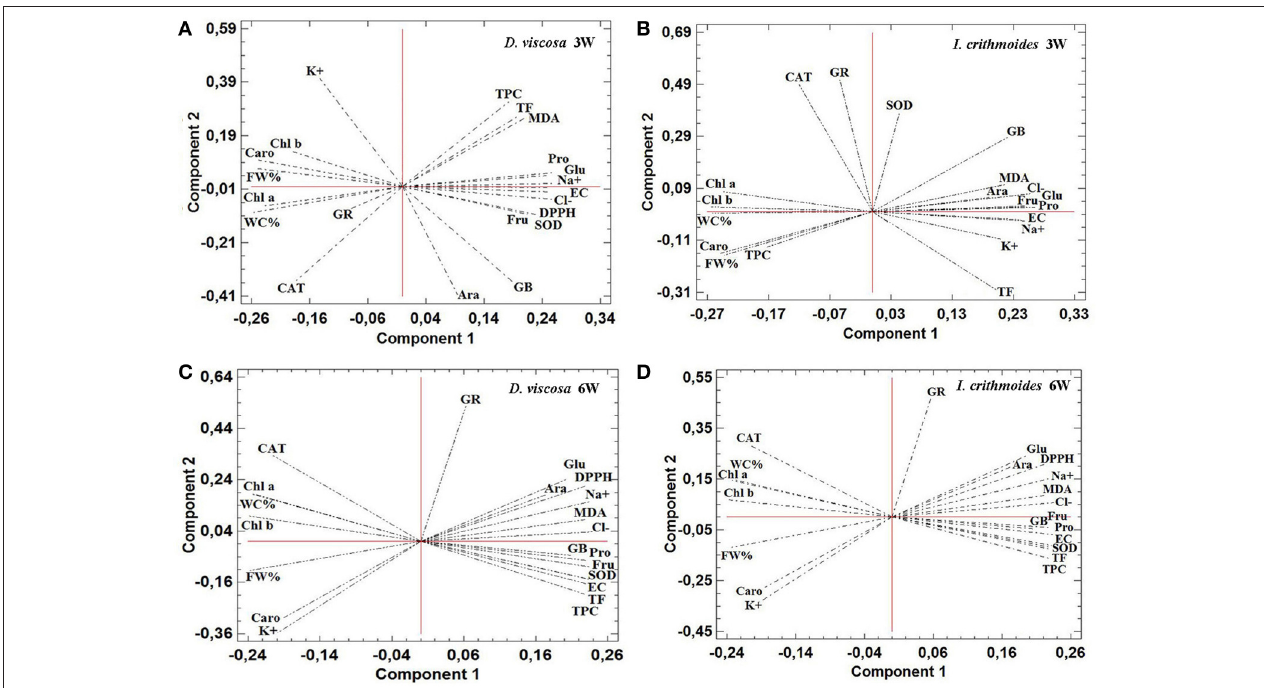
FIGURE 8 | Principal Component Analysis (PCA). Site score plots of the studied variables on the two principal components (1 and 2) for D. viscosa (A,C) and I. crithmoides (B,D) plants, after 3 weeks (A,B) and 6 weeks (C,D) of salt treatments. PCAs included, as the analyzed variables: electrical conductivity of the substrate at the end of the salt treatments (EC), fresh weight percentage (FW%), water content percentage (WC%), chlorophyll a (Chl a), chlorophyll b (Chl b), total carotenoids (Caro), sodium ions (Na + ), potassium ions (K + ), chloride ions (Cl − ), glycine-betaine (GB), proline (Pro), arabinose (Ara), fructose (Fru), glucose (Glu), malondialdehyde (MDA), total antioxidant activity—DPPH scavenging activity—(DPPH), total flavonoids (TF), total phenolic compounds (TPC), and specific activity of catalase (CAT), glutathione reductase (GR), and superoxide dismutase (SOD). Values of the different parameters were obtained from the experiments shown in Figures 3 – 6 and Tables 1 – 4 , and in “Supplementary Material” Table